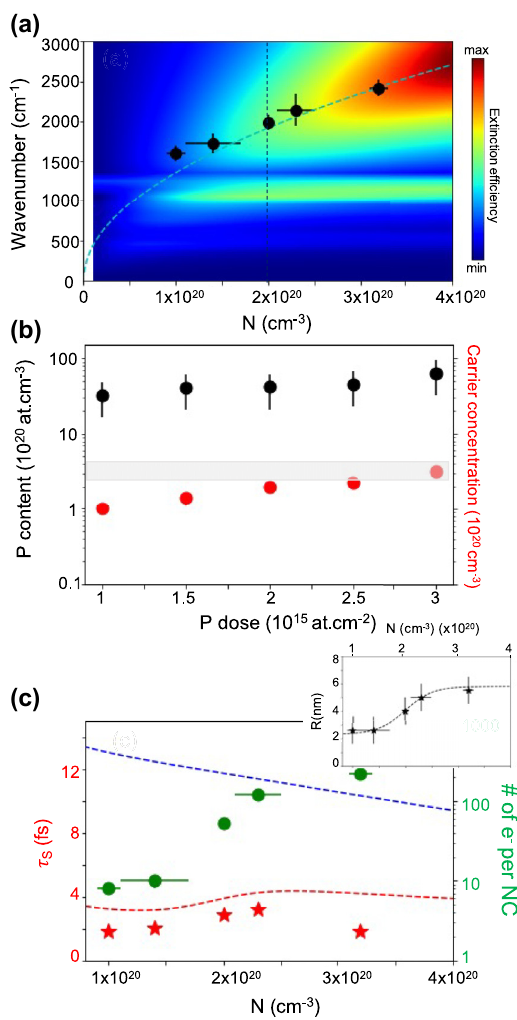
) versus carrier density (black Figure 4: (a) Energy of the LSPR ( 𝜔 P dots) deduced from the fitting procedure depicted in Figure 3. Color map: GDM calculations, frequency dependent extinction versus carrier density. Dashed blue line: exact Mie solution for spherical particle (from Eq. (3)). Vertical dashed line: Cut of the color map along this line is the yellow curve shown in Figure 3c. (b) P concentration inside big particles measured by STEM-EDX (black dots) and carrier concentration measured by FTIR (red circles) as a function of P dose. The range of experimental values for electrical solubility of P in bulk Si at 1050 ◦ C is represented by the grey rectangle [35]. (c) Left axis: scattering time versus carrier density extracted from fitting procedure (red stars). Dashed blue line: Si ( N ) [36]. Red dashed line: effective bulk scattering time 𝜏 bulk ( N ) deduced from Eq. (4). Right axis: average scattering time 𝜏 eff number of electrons in each NC contributing to the plasmon resonance versus carrier density (green circles). Inset: black dot: measured average size of the doped Si-NCs versus carrier density. Dashed black line: SiNCs radius r ( N ) used in Eq.